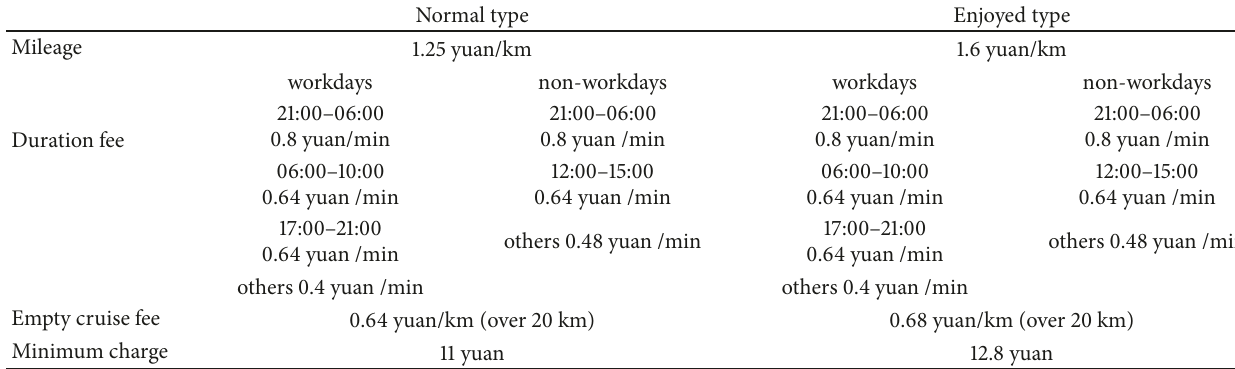
Table 2: Charge standard of Beijing